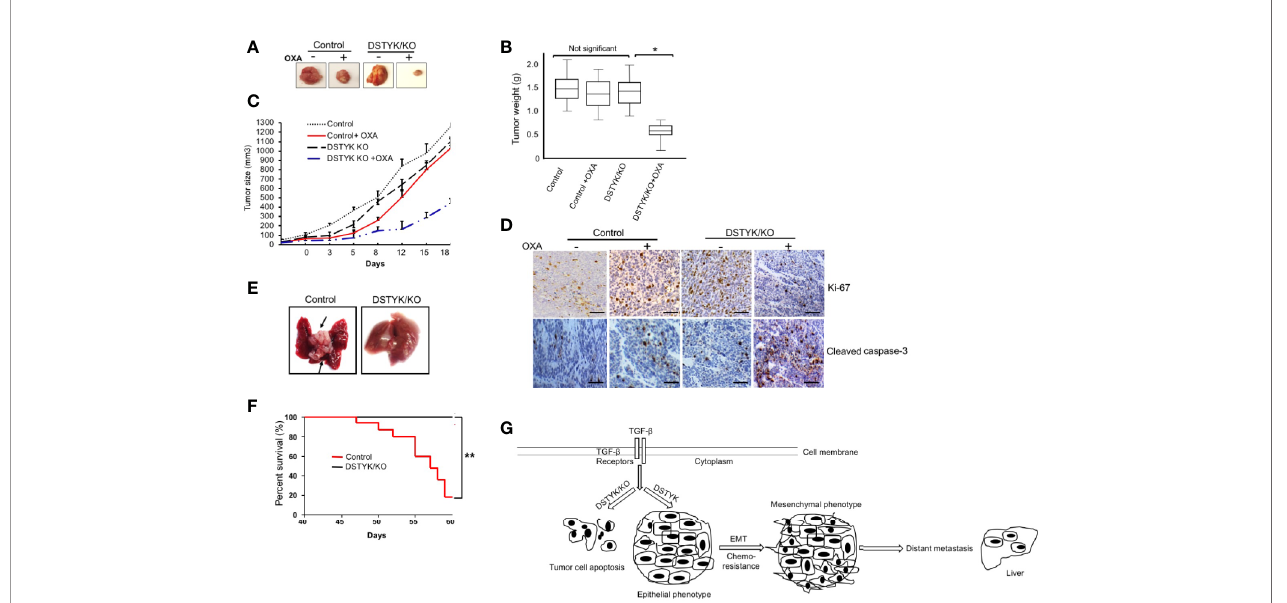
FIGURE 6 | DSTYK knockout facilitates tumor regression after OXA treatment. For each mouse, control LS411N-T b RII cells were implanted into the right fl ank and DSTYK/KO LS411N-T b RII cells were implanted into the left fl ank (n=20 per group). After around 3 weeks, mice carrying two tumors of similar size (tumor diameter is around 50 mm as measured with a caliper) started receiving OXA twice weekly. A tumor volume of 1300 mm 3 was de fi ned as the survival endpoint. Tumors were excised (A) and tumors ’ weights were evaluated as a box-and-whisker plot (B) . Data is presented as mean ± SD. (C) The growth curves of control tumors and DSTYK/KO tumors with and without OXA treatment, n=10 per group. (D) The levels of Ki-67 and cleaved caspase-3 in tumors tissues from LS411N-T b RII control cells and LS411N-T b RII DSTYK/KO cells detected by immunohistochemical analyses. Scale bar, 50 µm. (E) Representative images of liver metastasis (arrows). (F) Kaplan-Meier curve assessing the survival of SCID mice injected with LS411N-T b RII control cells or LS411N-T b RII DSTYK/KO cells in cecum wall (n=10/group, 3x). *P < 0.05; **P < 0.01. (G) The proposed model for the mechanism underlying the expression and function of DSTYK in TGF- b -induced EMT and